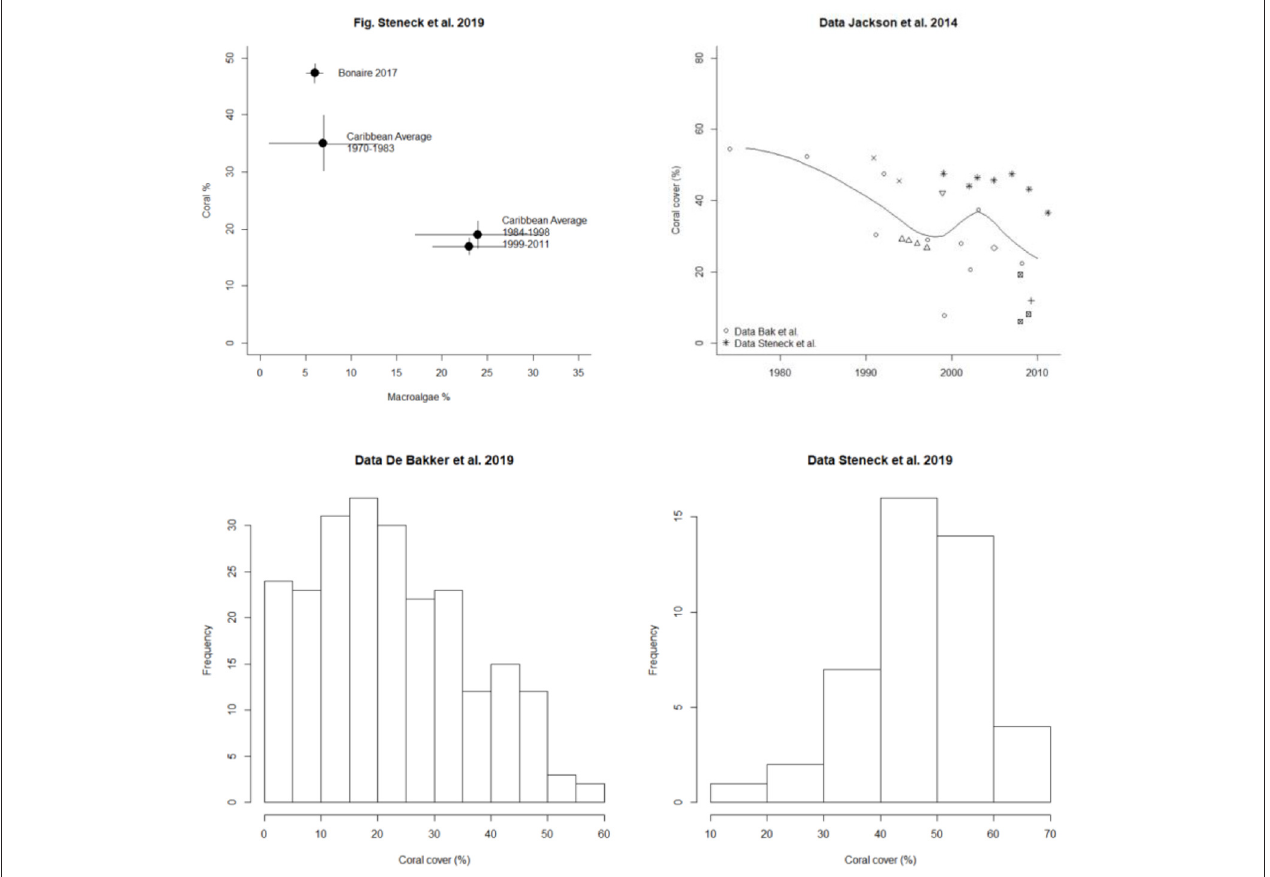
FIGURE 1 | Upper row: left, Figure 10, redrawn from Steneck et al. (2019), indicating the status of Bonaire in relation to previous published data by Jackson et al. (2014); right, Figure 6.2A redrawn from Jackson et al. (2014) indicating coral cover time series data for Bonaire from 8 different research groups (i.e., different symbols). Trend line is a LOESS smoother as in the original publication. Lower row: left, frequency histogram of our coral cover data of 230 transects on 115 sites on Bonaire at 10m depth; right, frequency histogram of the transect data (same depth) of Steneck et al. (2019). Data in upper row have been taken from publication using digitizing software (Poisot,